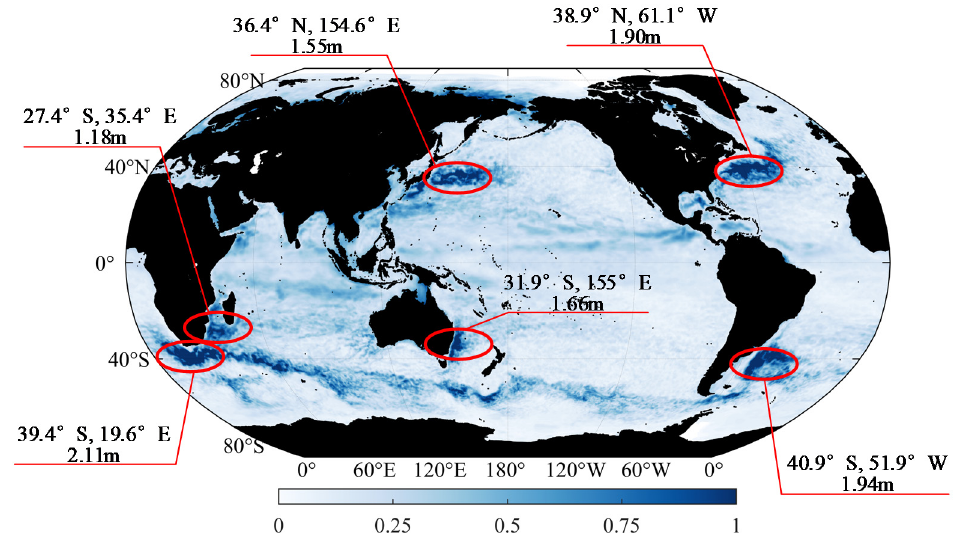
Figure 3. Annual range of global sea level anomalies in 2020 (unit: m).